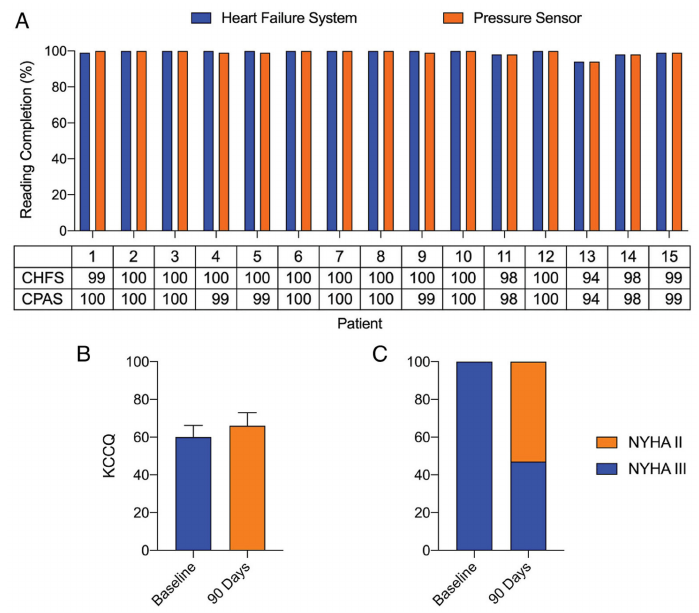
Figure 6. Summary of the results from the SIRONA study. Patient adherence, quality of life and New York Heart Association (NYHA) classification. ( A ) Patient adherence with daily Cordella Heart Failure System (CHFS) and Cordella Pulmonary Artery Pressure Sensor (CPAS) readings over the first 90days following implantation. ( B ) Kansas City Cardiomyopathy Questionnaire (KCCQ) score at baseline and 90days following implantation. ( C ) NYHA classification at baseline and 90days following implantation. Reprinted from European Journal of Heart Failure Volume 22, Issue 10, Mullens et al., Digital health care solution for proactive heart failure management with the Cordella Heart Failure System: results of the SIRONA first-in-human study, pages 1912–1919, Creative Commons CC BY license